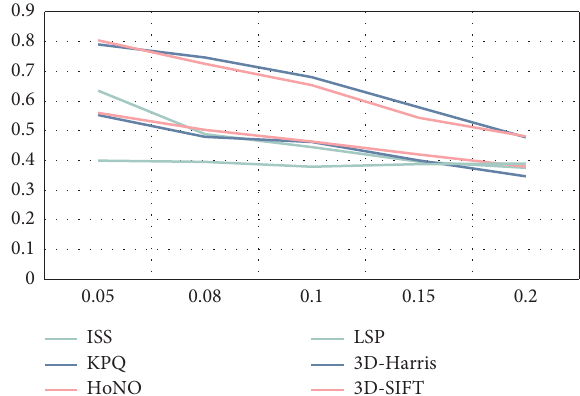
of the key point noise